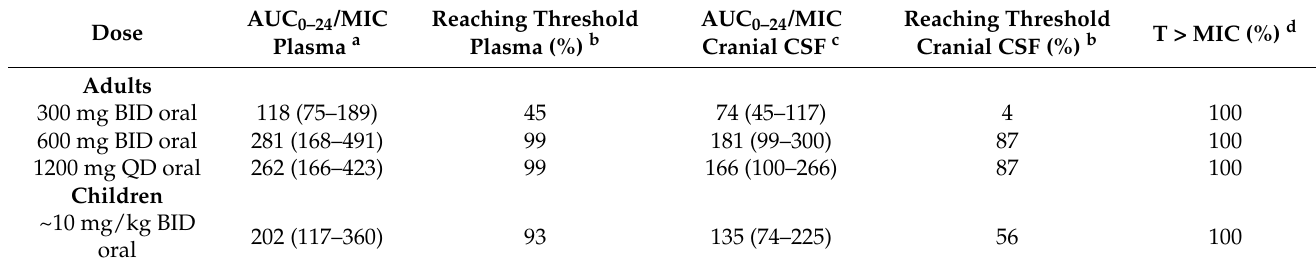
Figure 3. Simulations of linezolid concentration–time profiles in plasma and cranial CSF in adults ( A , B ) and paediatric ( C , D ) TB patients. The results relate to oral administration of 600 mg (adults) or 9.24 mg/kg (children; 0.6–9.4 years) linezolid twice daily. The x -axis indicates time after the last dose. The solid black lines indicate simulation of the mean profile, the grey areas represent the area between the 25th and 75th percentile ( A , B ) or 16th and 84th percentile (equal to the standard deviation) of the mean ( C , D ), and the dotted lines indicate the 5th and 95th percentiles of the mean. Open black circles and open light grey squares indicate median with interquartile range from the literature [30,31]. Closed dots indicate measured individual data derived from literature [29]. Dashed horizontal line indicate the MIC value of 1 mg/L linezolid for Mycobacterium tuberculosis [30,31]. In the clinical studies, linezolid was provided in addition to standard care. Table 1. Predicted PK–PD indices per dosing regimen.